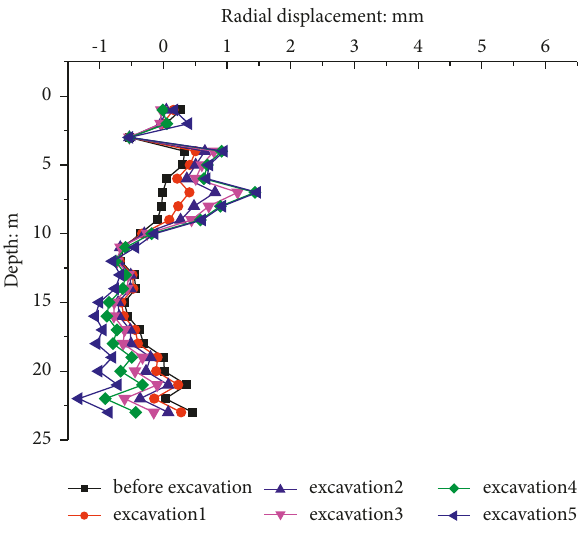
Figure 33: The horizontal displacement of # 3 measuring point changes with